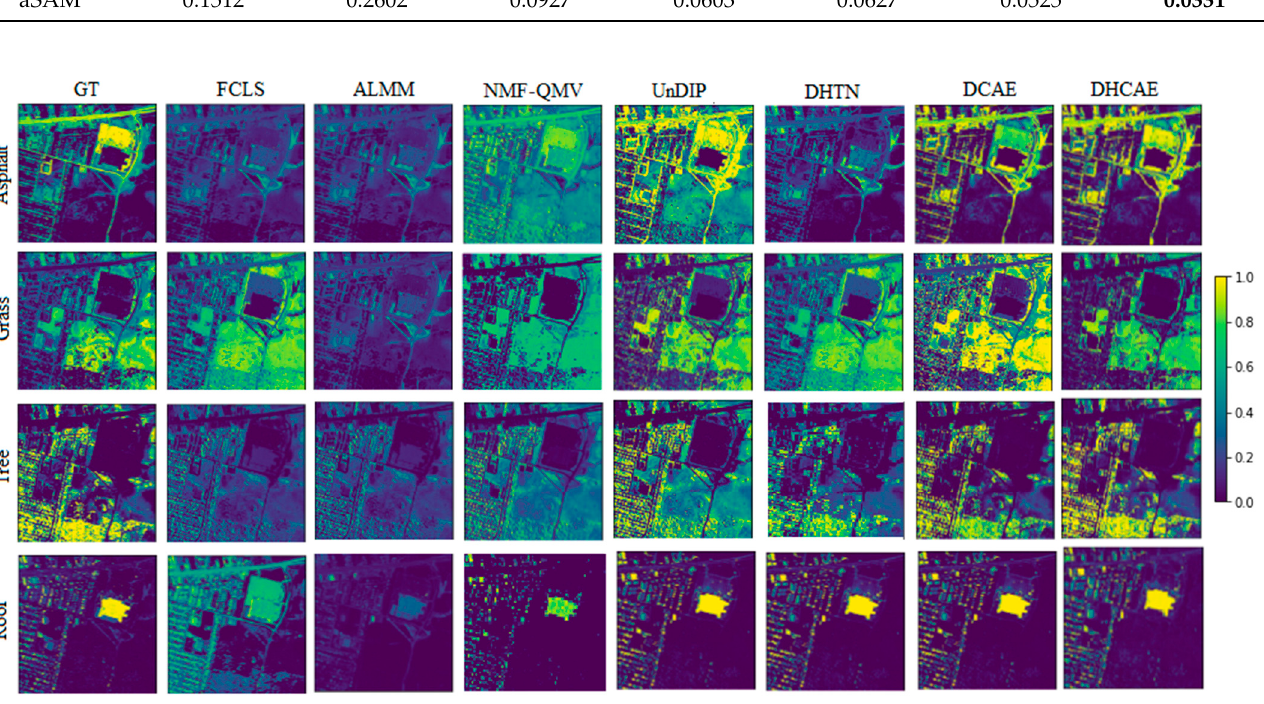
Figure 12. Urban data. Ground truth (GT) map in the first column and extracted abundance maps with remove noisy bands comparison by different spectral unmixing